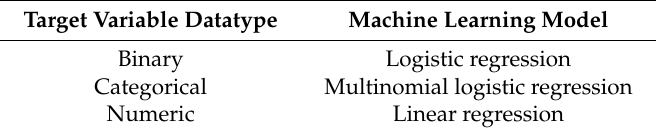
Table 4. The Amazon Web Services Machine Learning (AML) machine model selection based on the target variable datatype.